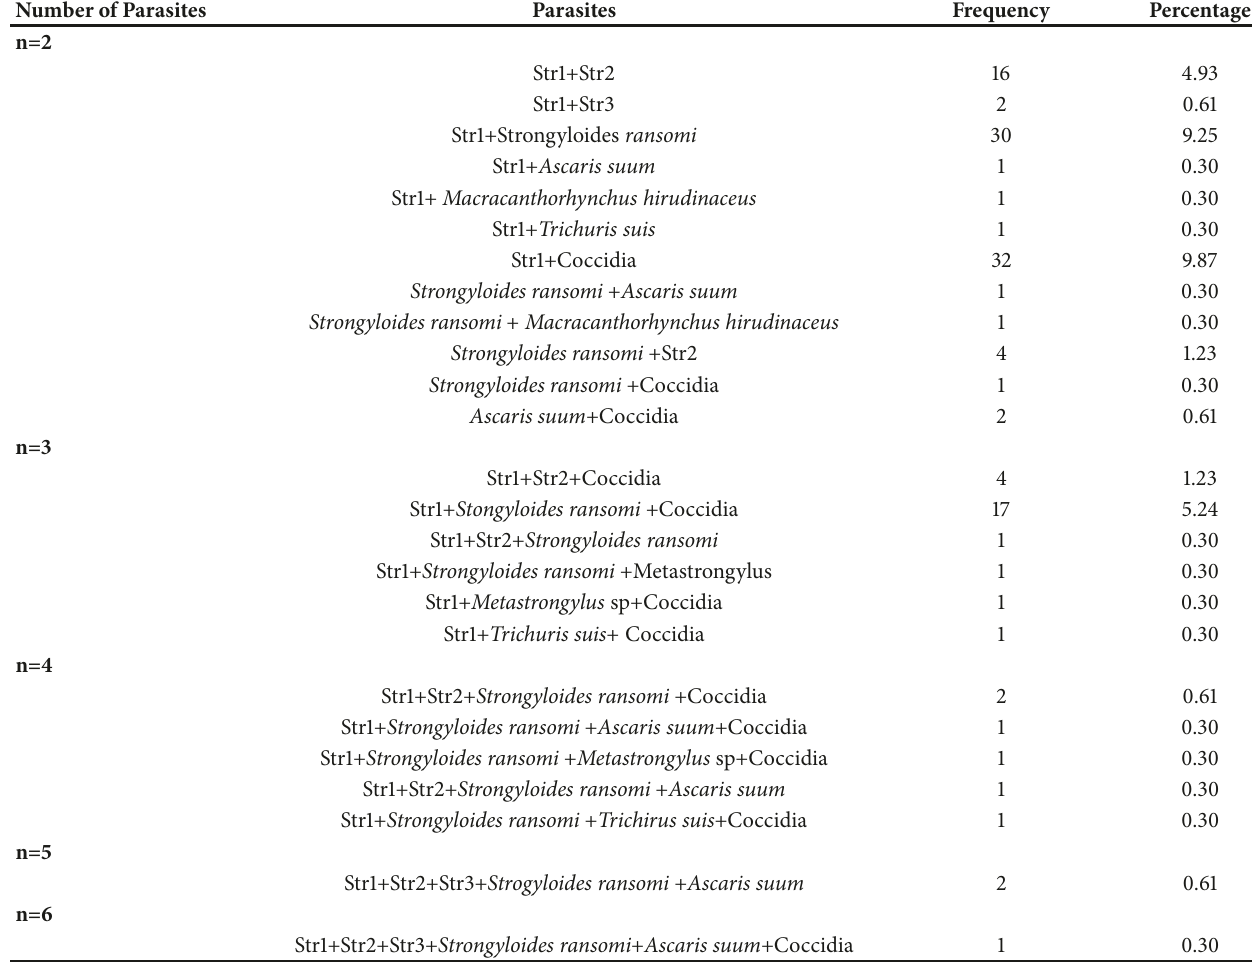
Table 2: Distribution of concomitant infestations in indoor pigs in Bamboutos, Cameroon. Number of